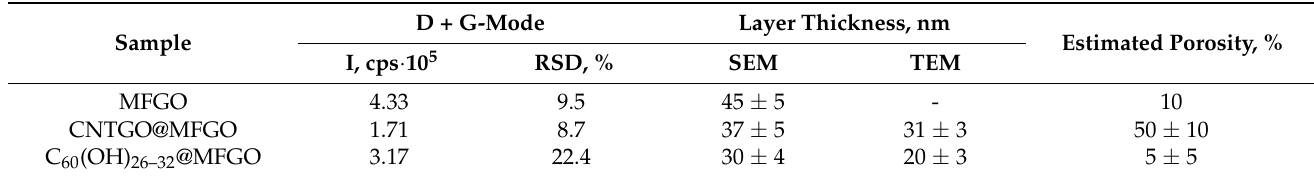
Table 1. Microstructural parameters and statistical analysis of Raman maps for the graphene-oxide- based selective layers of the composite membranes.